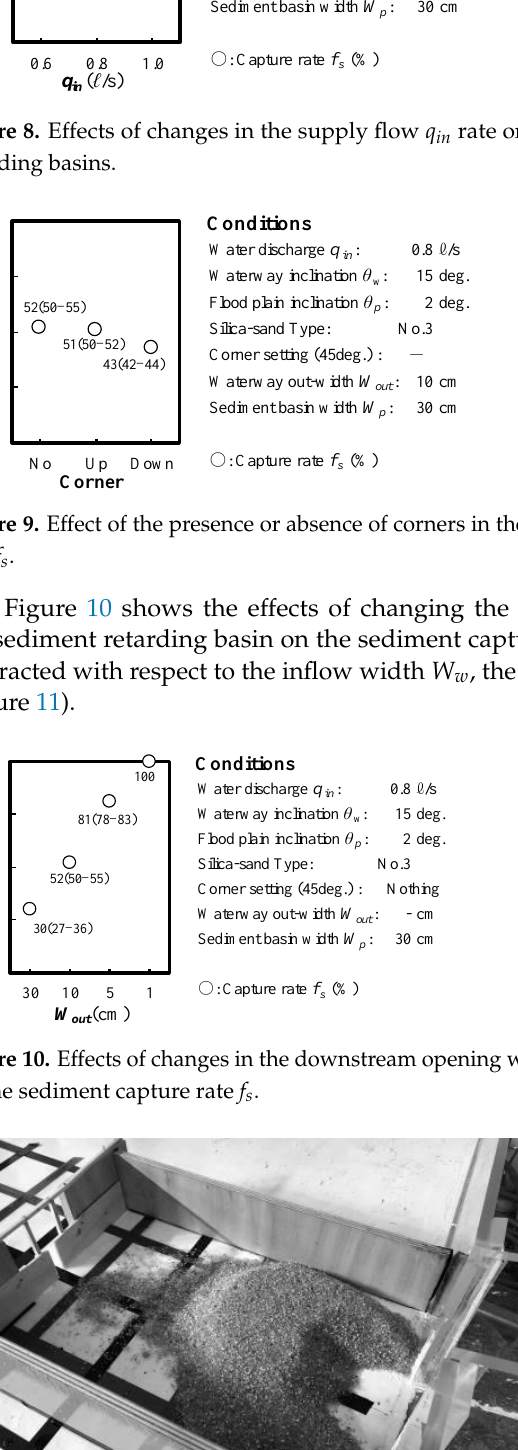
Figure 10. Effects of changes in the downstream opening width W out of the sediment retarding basins on the sediment capture rate f s .